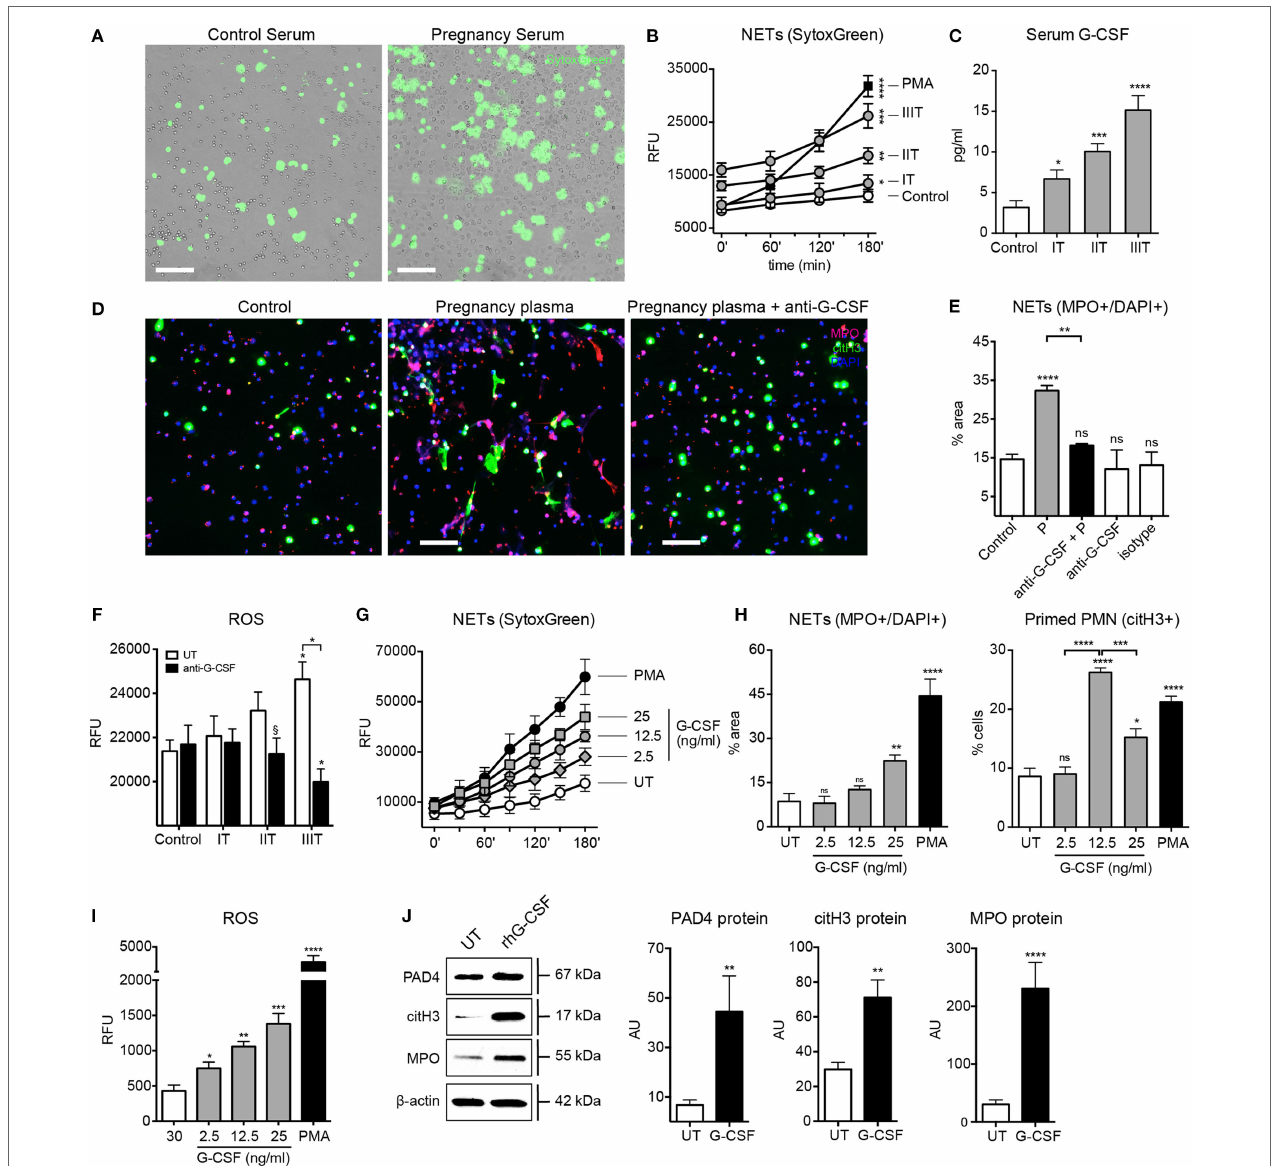
FigUre 2 | g-csF leads to neutrophil pro-neTotic priming during the course of pregnancy . (a) In vitro spontaneous extracellular DNA release monitored over a 3-h time course by SytoxGreen dye fluorescence microscopy after treatment of control neutrophils with pooled sera from women during their pregnancy. Scale bars: 100 μ m. (B) Fluorimetric quantification of extracellular DNA release from neutrophils treated in vitro with serum from the three trimesters of pregnancy using dsDNA-binding SytoxGreen dye compared to the NET-inducing phorbol ester PMA (25nM). (c) Detection of G-CSF levels in sera from donors during the three trimesters of pregnancy by EIA. (D) Fluorescent immunostaining for MPO (red), citH3 (green), and DNA (blue) depicting the formation of NETs after in vitro treatment of control neutrophils with 6% pooled plasma from women during their pregnancy and 30 min pretreatment of pregnancy plasma with 50 ng/ml anti-G-CSF neutralizing antibody compared to plasma from control non-pregnant individuals. Scale bars: 50 μ m. (e) Quantitative morphometric analysis of the NETotic (MPO + /DNA + ) positive and pro-NETotic primed (citH3 + ) neutrophils from healthy non-pregnant donors under the aforementioned experimental setup. (F) Intracellular ROS generation from neutrophils cocultured in vitro with 6% plasma derived from donors during the three trimesters of pregnancy and 50 ng/ml anti-G-CSF neutralizing antibody monitored with DCFH-DA. (g) Evaluation of rhG-CSF activity by in vitro titration experiments using fluorimetric analysis of control neutrophils after in vitro incubation with 2.5, 12.5, and 25 ng/ml rhG-CSF compared to untreated (UT) and treated with PMA (25nM) neutrophils. (h) Morphometric analysis of the NETotic (MPO + /DNA + ) and pro-NETotic primed (citH3 + ) neutrophils from healthy control donors under rhG-CSF treatment in vitro at the indicated concentrations compared to untreated (UT) and PMA-treated neutrophils. (i) Oxidative burst in neutrophils from healthy control donors treated in vitro with rhG-CSF at the indicated concentrations monitored by DCFH-DA detection and compared to untreated (UT) and PMA-treated neutrophils. (J) Western blot and densitometric analysis of PAD4, citH3, MPO, and beta-actin protein expression in neutrophil lysates from healthy female controls treated in vitro with the physiological concentrations of rhG-CSF (12.5 ng/ml). Data are presented as mean ± SEM. * P < 0.05, ** P < 0.01, *** P < 0.001, and **** P < 0.0001 (one or two way ANOVA followed by Bonferroni’s multiple comparison post-test). All experiments were performed at least six times with consistent results. IT, first trimester; IIT, second trimester; IIIT, third trimester; RFU, relative fluorescence